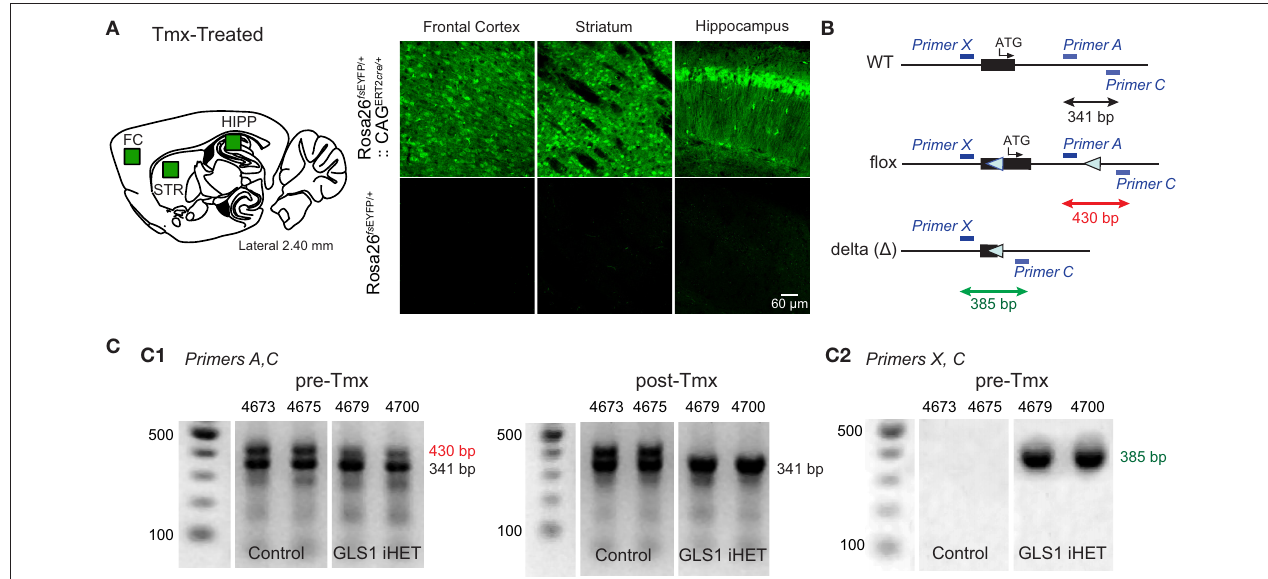
FIGURE 2 | Tamoxifen induction of GLS1 deficiency. (A) Test for universal cre action. CAG ERT2 cre / + :: Rosa26 fs EYFP / + mice and control Rosa26 fs EYFP / + mice were treated with Tmx, and their brains subsequently immunostained to visualize EYFP, in the frontal cortex, striatum and hippocampus, as indicated on the sagittal brain section schematic ( left ). Confocal images revealed ubiquitous EYFP expression in CAG ERT2 cre / + :: Rosa26 fs EYFP / + , but not Rosa26 fs EYFP / + mice. (B) Primer strategy used to determine the presence of WT, floxed, and recombined ( 1 ) GLS1 alleles. Blue bars indicate the locations of the three primers used. Black arrow indicates length of the amplified WT allele, the red arrow the floxed allele and the green arrow the recombined ( 1 ) allele. (C) PCR genotyping of tail samples from control and GLS1 iHET mice pre- and post-Tmx. Gels from two mice of each genotype are shown, with mouse identification numbers. Band sizes are shown to the right of the gels. (C1) Gel electrophoresis ( left ) showed both floxed and WT DNA bands (with Primers A,C ) prior to Tmx (Pre-Tmx) administration in GLS1 iHET and Control mice, whereas post-Tmx ( right ), the floxed DNA band remained in Control (GLS1 lox / + ) mice, but was eliminated in GLS1 iHET mice. (C2) Gel electrophoresis with Primers X, C identified the presence of a 1 allele in GLS1 iHET mice prior to Tmx treatment, revealing “leaky” cre-mediated recombination.